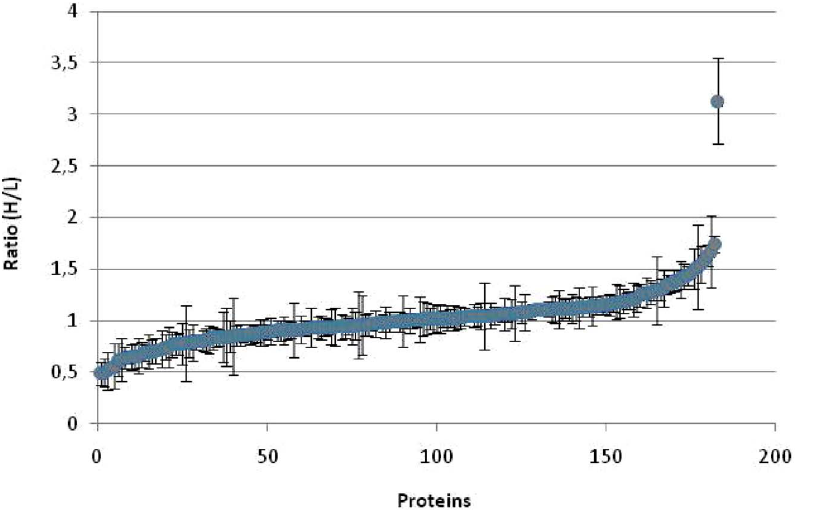
Figure 4. Distribution of the fold-changes of all proteins quantified (185) in both biological replicates of the LD growth cycle using the post-digest ICPL method.